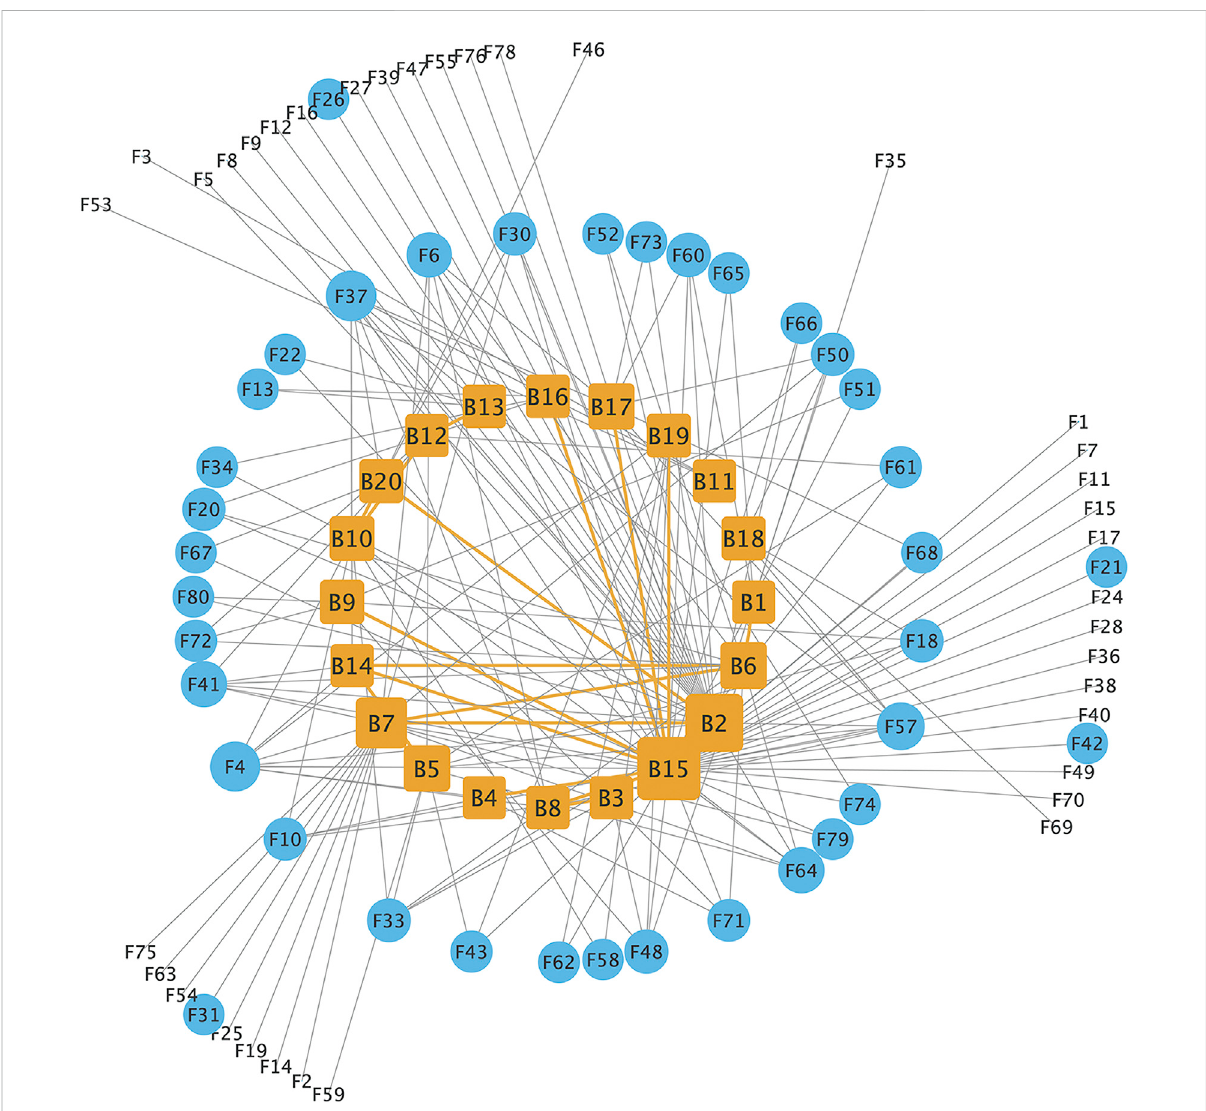
FIGURE 1 An example diagram of the multi-layer fi nancial network (The fi gure contains 20 banks and 80 fi rms. The orange rectangular nodes represent the banks, and the blue circular nodes represent the fi rms in the system; The orange lines represent interbank lending linkages, and grey lines represent bank- fi rm credit